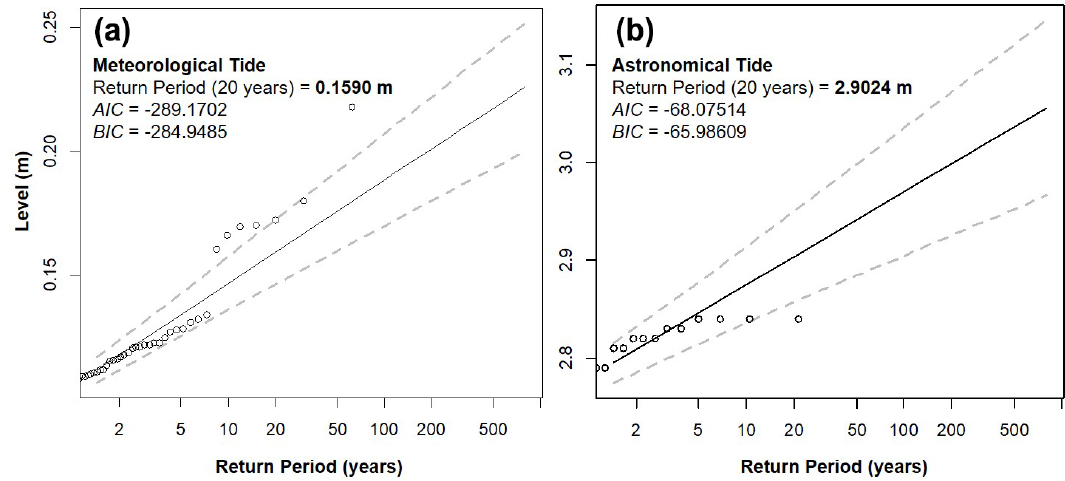
Figure 5. Return period graph of tide data: (a) meteorological tide and (b) astronomical tide. Table 4. Tidal flood quotas in the scenarios under study.